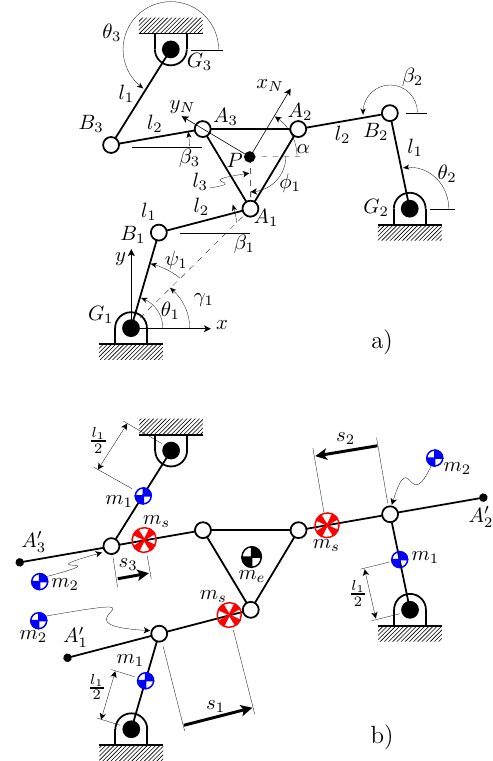
Fig. 2: 3-RRR planar manipulator: a) basic kinematic parameters Figure 2. 3-RRR planar manipulator: (a) basic kinematic parame- ters and (b) location of the centre of mass of each component ( l i are and b) location of the centre of mass of each component ( l i are fixed values while s i are variable). fixed values while s i are